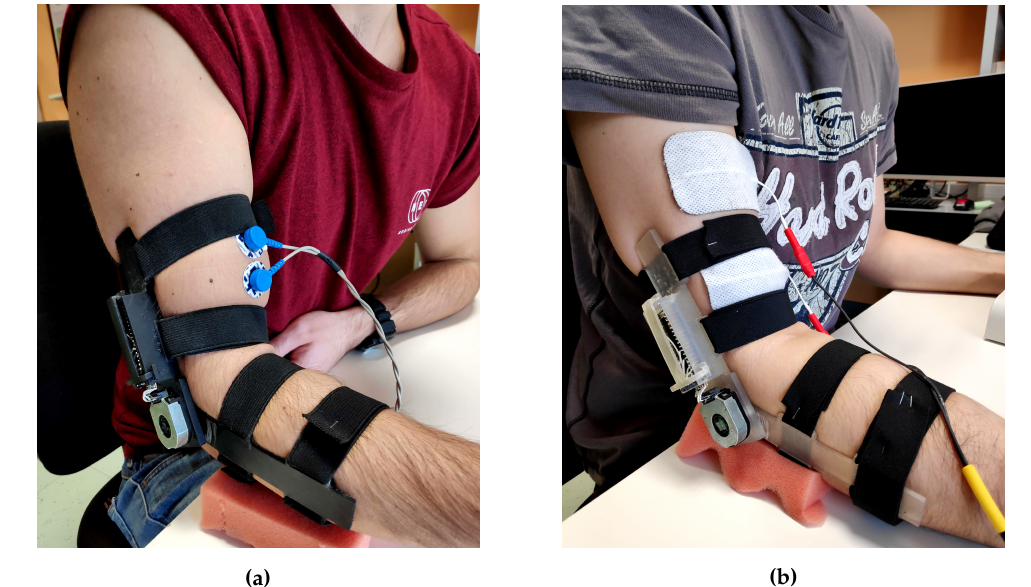
Figure 11. Acquisition ( a ) and stimulation ( b ) electrodes location, on the biceps femoris muscle, for the EF